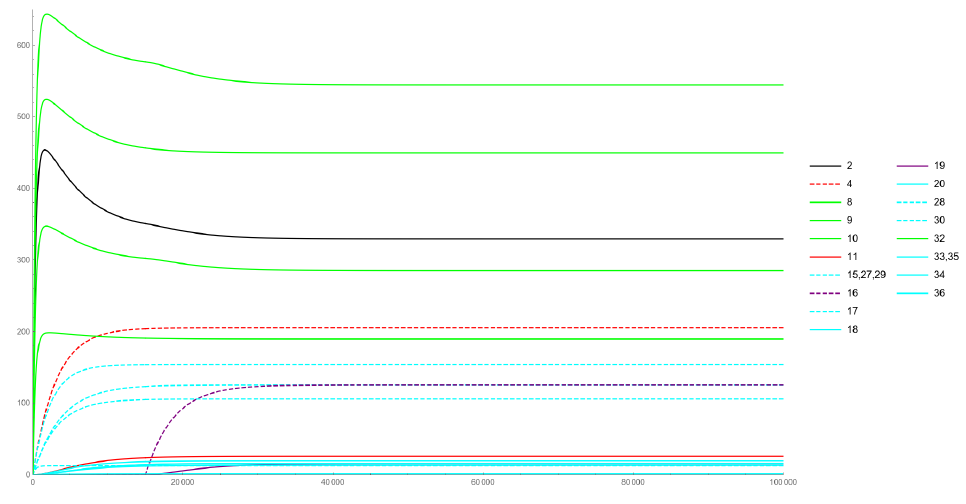
Figure 4. Ectopic Expression